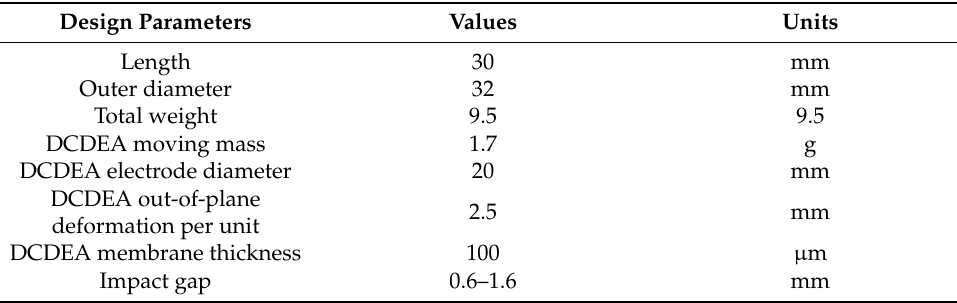
Table 1. Key design parameters of the vibro-impact crawling